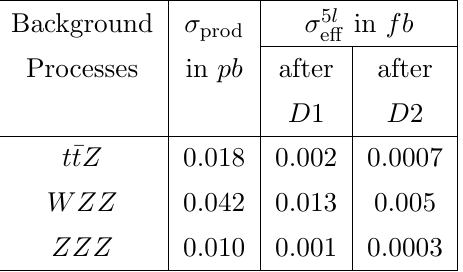
) after the cuts of di(cid:11)erent back- e(cid:11)